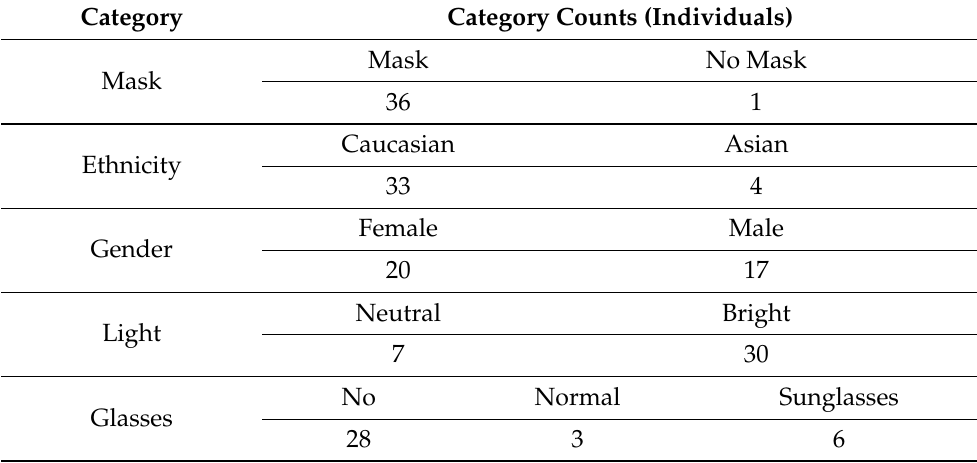
Table 7. Results of live recordings across 5 categories for describing attributes of individuals’